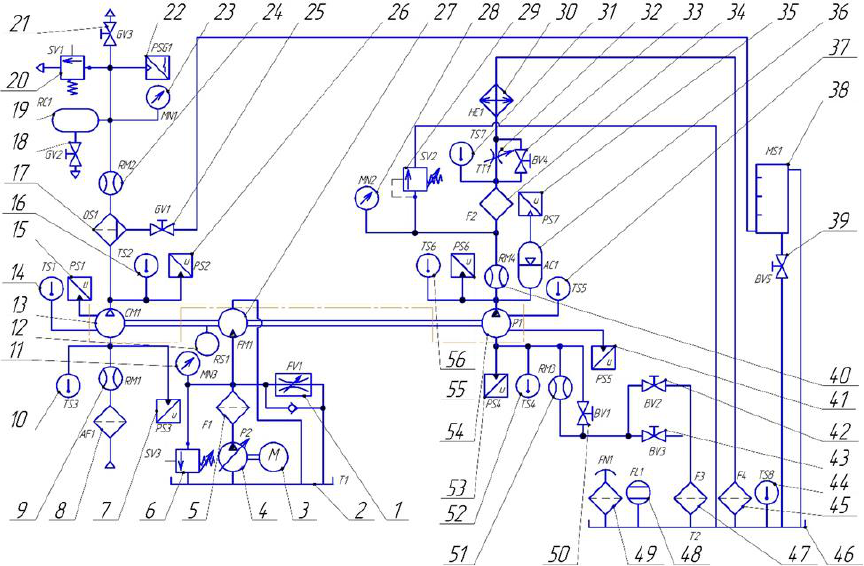
Figure 6. Hydropneumatic diagram of the experimental stand for two-stage PHPM studying. Leg-